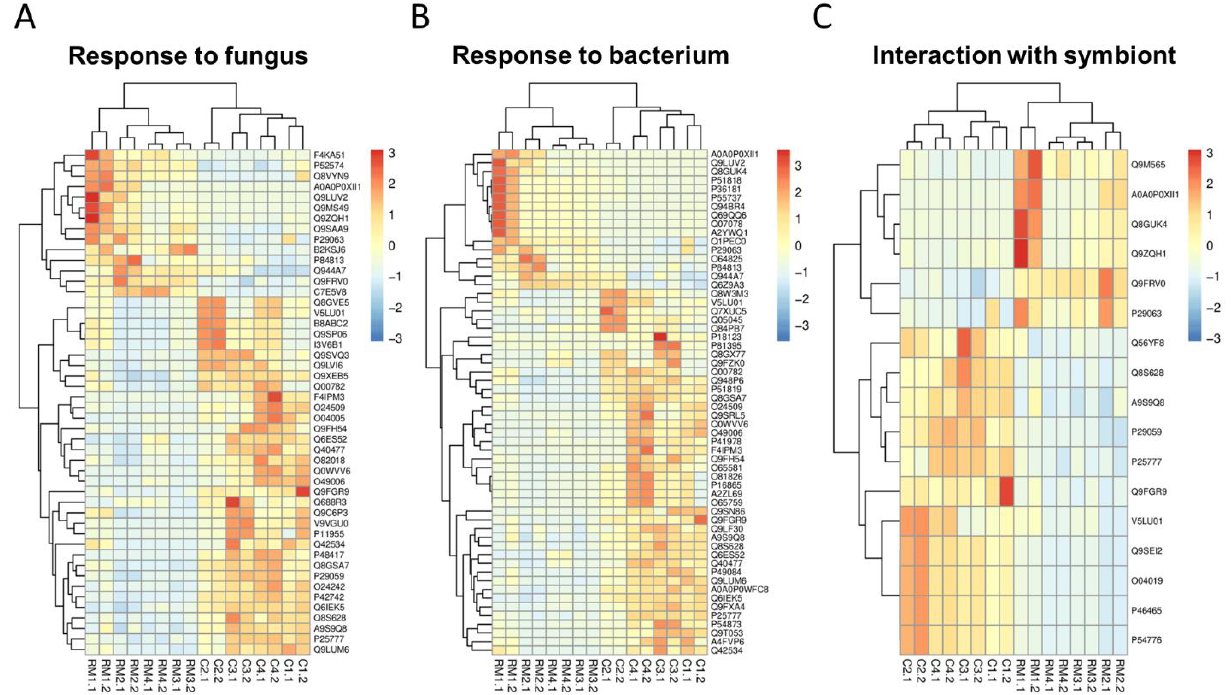
Figure 4. Hierarchical clustering of differentially abundant proteins related to biotic stimulus in M. acutistipula sampled from RM (RM1.1, RM1.2, RM2.1, RM2.2, RM3.1, RM3.2, RM4.1, and RM4.2) and canga (C1.1, C1.2, C2.1, C2.2, C3.1, C3.2, C4.1, and C4.2). ( A ) Response to fungus. ( B ) Response to bacterium. ( C ) Interaction with symbiont. The red and blue colors represent the highest and lowest intensity values, respectively. The accession numbers represent the proteins used for the analysis and can be viewed in Dataset S1.